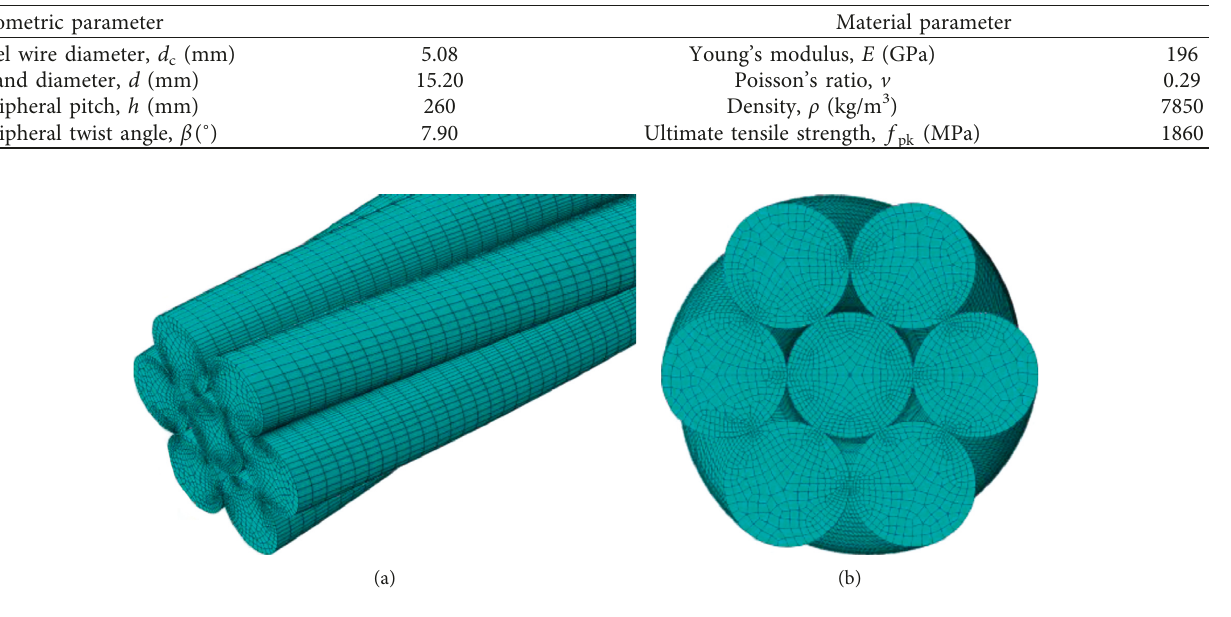
Figure 2: Finite element calculation model of steel strand.